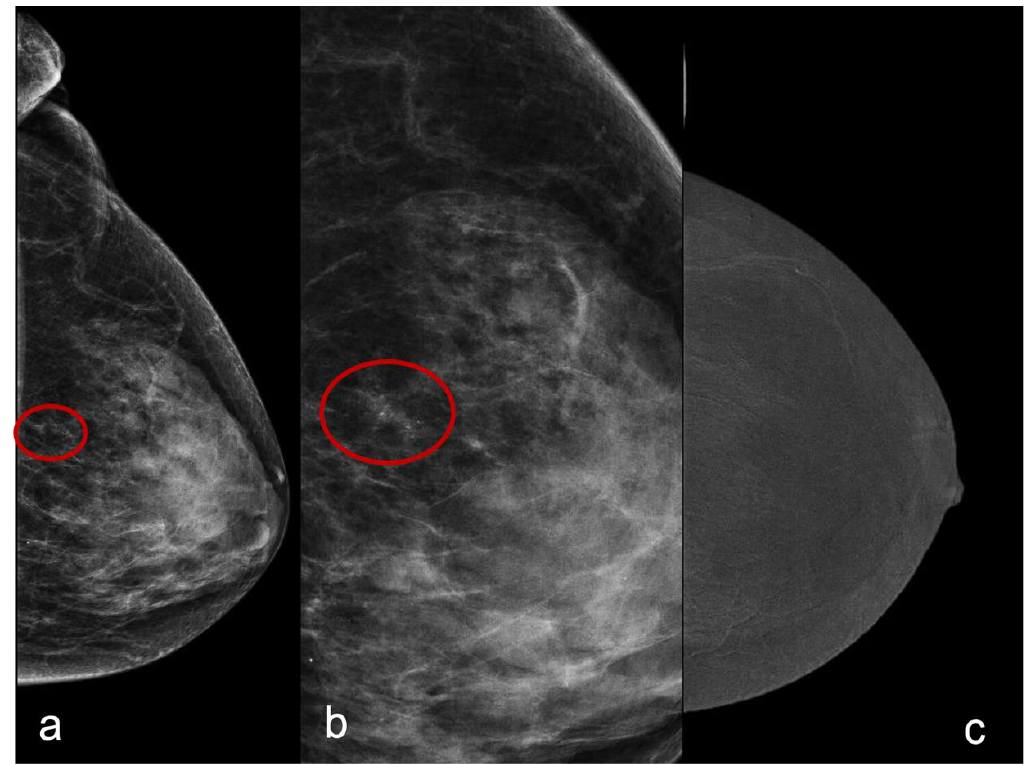
Figure 1. A craniocaudal mammography image of a 56-year-old with a cluster of microcalcifications ( a ). In ( b ), we can appreciate the magnification of the cluster of microcalcifications. There is no evidence of enhancement (score 0) in the CESM subtracted recombined image ( c ). Histology was fibrocystic disease.